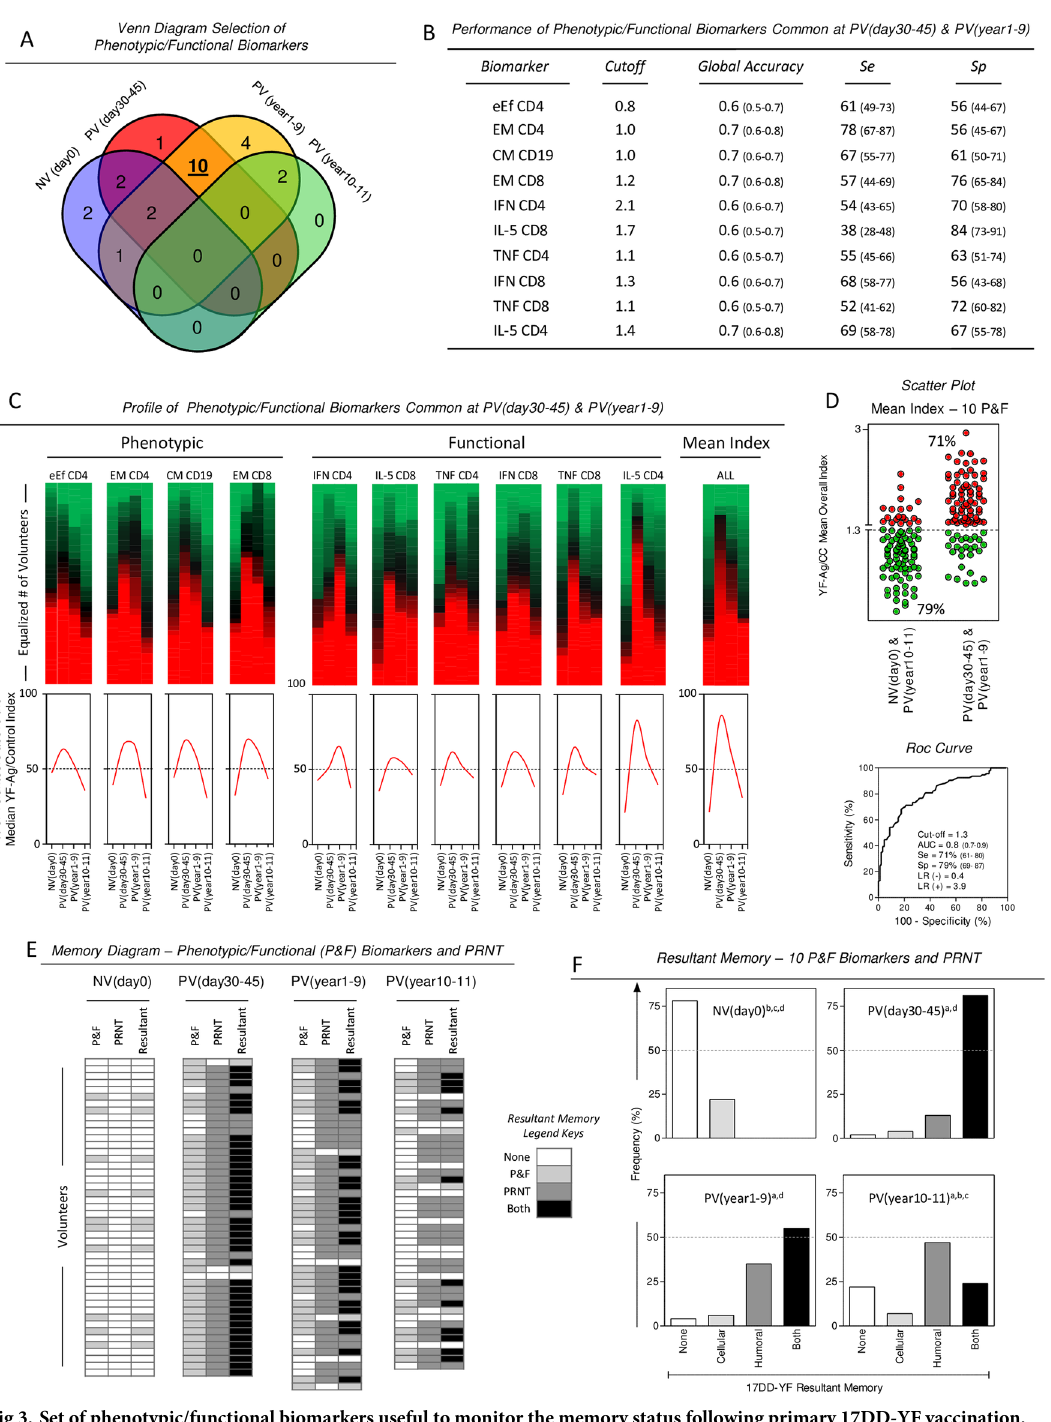
Fig 3. Set of phenotypic/functional biomarkers useful to monitor the memory status following primary 17DD-YF vaccination. (A) Venn diagram analysis was carried out to identify the intersection of phenotypic/functional biomarkers amongst NV(day0), PV (day30-45), PV(year1-9) and PV(year10-11) and select those common attributes between PV(day30-45) and PV(year1-9), considered biomarkers of protection. Detailed Venn Diagram report is provided in the S1 Table. (B) The performance indicators (cut-off, accuracy, sensitivity-Se and specificity-Sp) for the ten selected common biomarkers (eEfCD4, EMCD4, CMCD19, EMCD8, IFNCD4, IL-5CD8, TNFCD4, IFNCD8, TNFCD8 and IL-5CD4) are provided in the inserted table. (C) Heatmap analysis was carried out to illustrate the profile of phenotypic/functional biomarkers common at PV(day30-45) and PV(year1-9) as well as the mean index calculated considering all 10 phenotypic/functional biomarkers together and demonstrate the proportion (%) of volunteers presenting low (Green), median (Black) or high (Red) YF-Ag/CC index. Histograms were constructed to highlight the frequency of